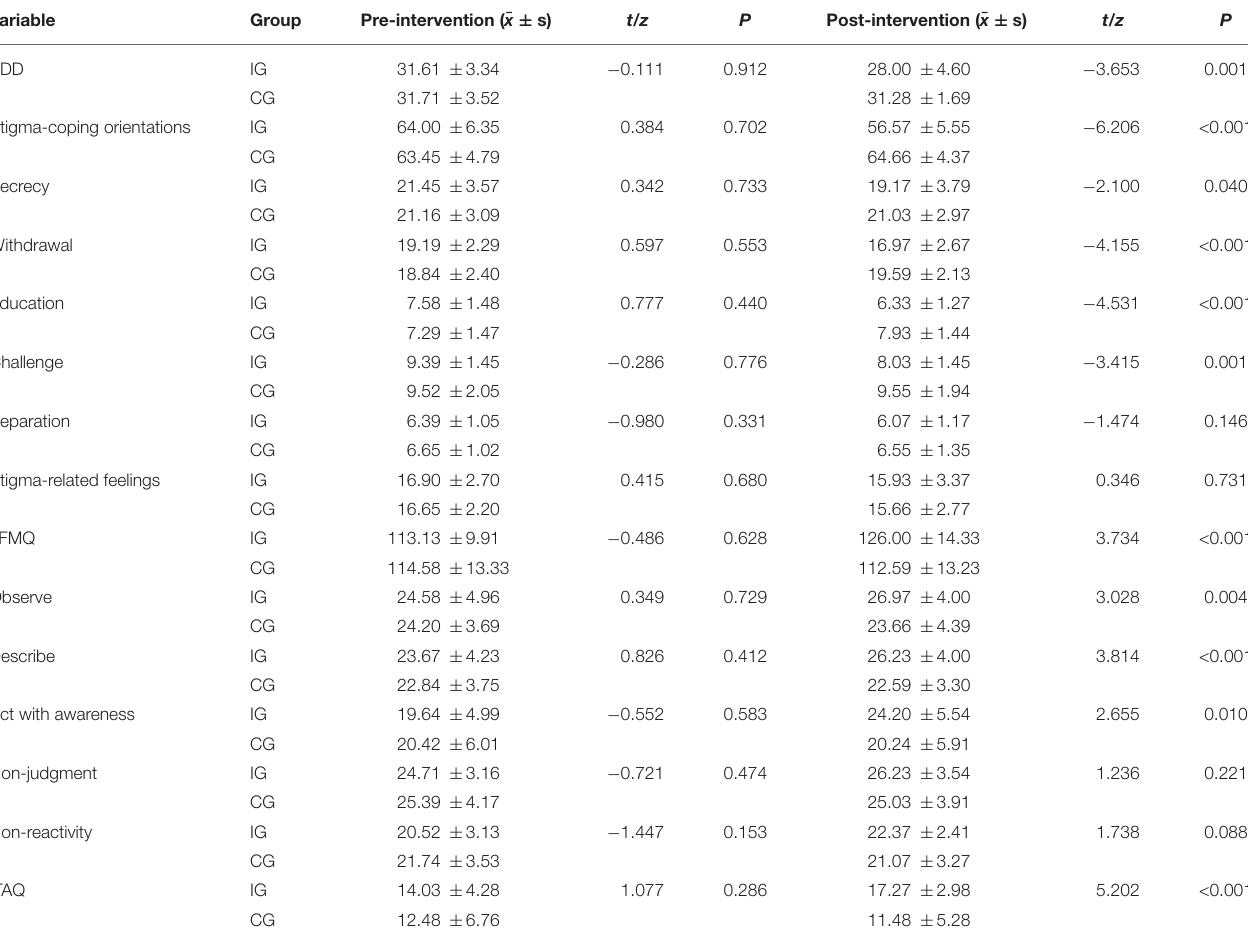
TABLE 4 | Comparison of the two groups before and after intervention.